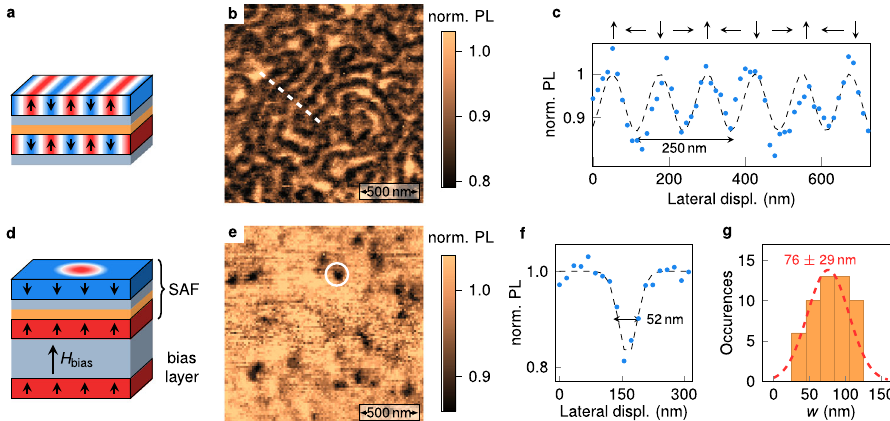
Fig. 5 Imaging antiferromagnetic spin spirals and skyrmions via single spin relaxometry. a Sketch of a SAF sample hosting a spin spiral. The composition of the stack is identical to the one shown in Fig. 2a, with a Co thickness ( t Co = 1.47 nm) leading to a SAF with vanishing magnetic anisotropy. b PL quenching image of a spin spiral state. c Line pro fi le along the white dashed line in b . d Sketch of a SAF sample including an additional bias layer which enables the transformation of the spin spiral into antiferromagnetic skyrmions. The composition of the bias layer is Ta(10)/Pt(8)/[Co(0.6)/Pt(0.45)] 3 . e PL quenching image showing antiferromagnetic skyrmions in the biased-SAF sample. f Line pro fi le across the skyrmion marked with the circle in e . The dashed line is data fi tting with a Gaussian function. g Statistical distribution of the full width at half maximum w of the PL quenching spots, inferred from measurements over a set of 52 isolated skyrmions. The red dashed line is a fi t with a normal